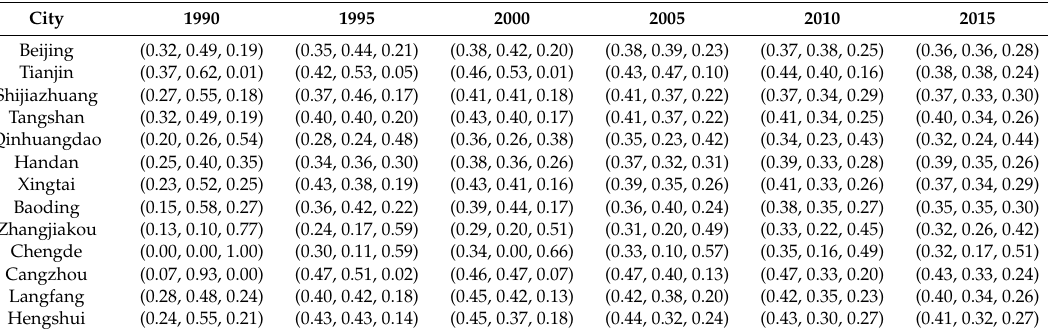
Table 3. The coordinates (production function, living function, ecology function) in the triangle model